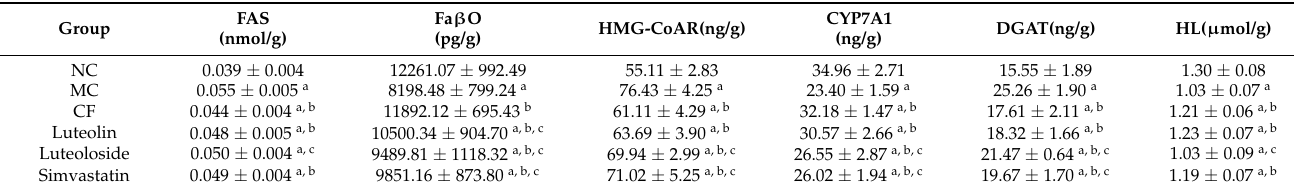
Table 10. Enzymes involved in fatty acid (FAS, FA β O), cholesterol (HMG-CoAR, CYP7A1), and triglycerides (DGAT, HL) metabolism in the